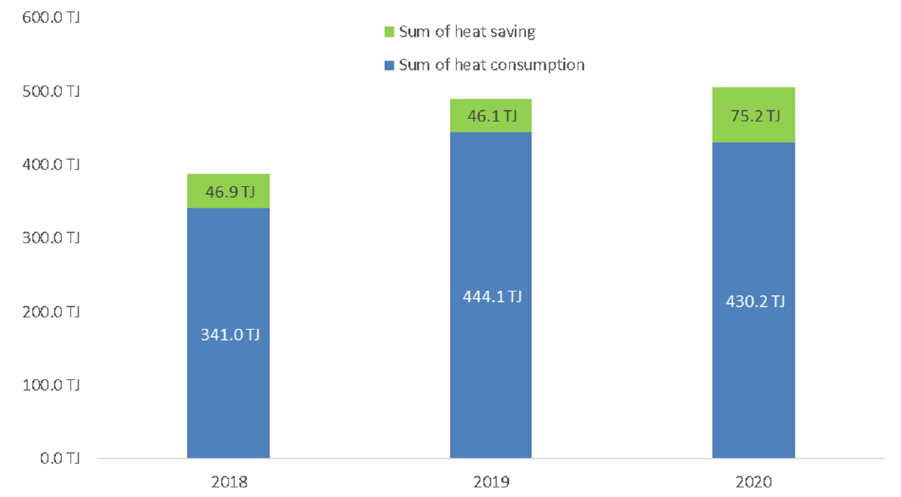
Figure 2. Consumptions and savings between 2018 and 2019 concerning baseline in the Warsaw DHN.